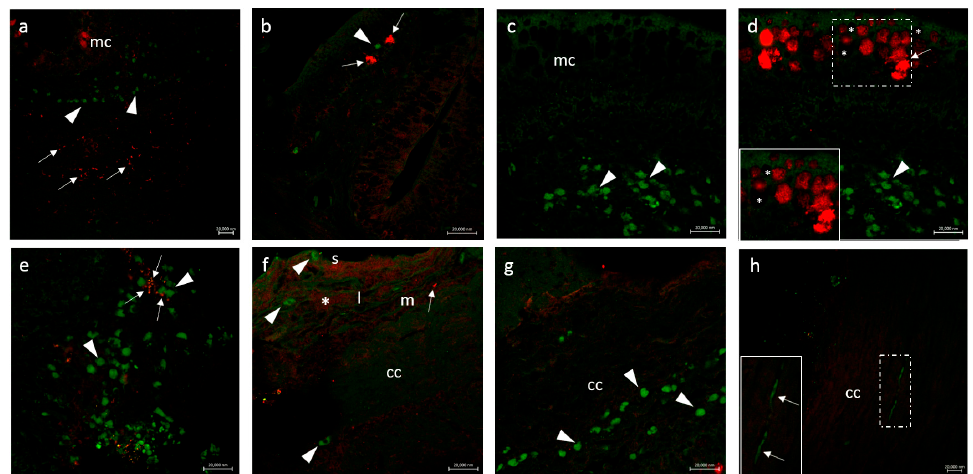
Figure 2. ( a – h ): Confocal images of African bonytongue and catfish intestines. Double immuno- labeling with antibodies against CD14 (green) and VAChT (red). ( a ) H. niloticus : confocal image highlighting the diversity of macrophage phenotypes containing CD14 (arrowheads) in the subepithe- lial layer and VAChT (arrows) in the muscularis-associated immunoreactivity in the middle intestine. Cholinergic mucous cells (mc) display VAChT immunoreactivity. ( b ) H. fossilis . Residing macrophage populations in the intestinal epithelium of pyloric caeca mucosal folds showing CD14 (arrowheads) and VAChT (arrows) immunoreactivity. ( c ) H. niloticus : distal intestine. VAChT-positive macrophages (arrowheads) with extending processes are observed in the mucosal layer engulfing mucous cells (mc) as compared with the lacking macrophage (arrow) occupation in ( d ) Large mucous cells (asterisks) are lightly stained. ( e ) H. niloticus . Distal intestine. Macrophages are visualized by antibody to CD14 (arrowheads) in the subepithelium to highlight their close contact with VAChT-positive nerve endings (arrows). ( f ) H. niloticus . Distal intestine CD14 positive macrophages (arrowheads) spanning the serosa (S), the longitudinal muscle (l), and the myenteric plexus (m). Note the close vicinity of the macrophages with the VAChT-positive nerve endings (asterisk); circular muscle (cc); macrophage of the enteric system (arrow). ( g ) H. niloticus . Distal intestine. Macrophages (arrowheads) spanning the circular muscle (cc) of the intestine highlight the diversity of the phenotype. ( h ) Macrophages (arrows) align with the muscle cells (cc). Scale bar ( a – h ) = 20